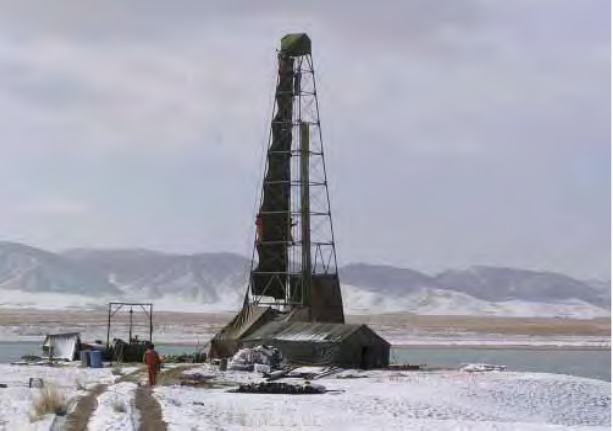
Figure 4. Yilang Jian land-based drill site on the shore of Lake Qinghai,